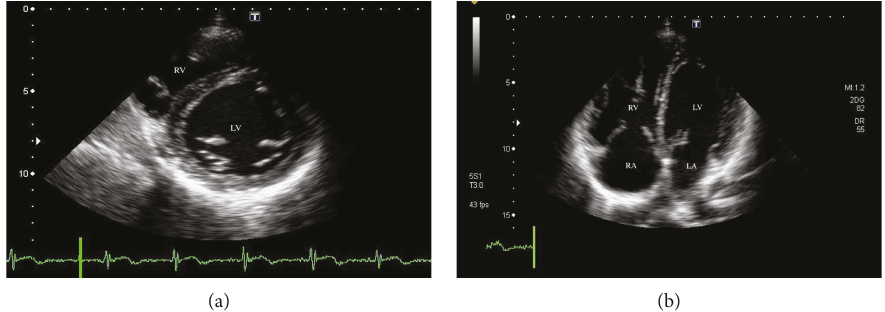
Figure 3: Follow-up echocardiography, 6 months after the upfront combination therapy. (a) Short axis view of the TTE showed no compression of the interventricular septum. (b) Apical four chambers view the TTE showed improvement of the right ventricular size. TTE: transthoracic echocardiography; LV: left ventricular; LA: left atrium; RV: right ventricular; RA: right